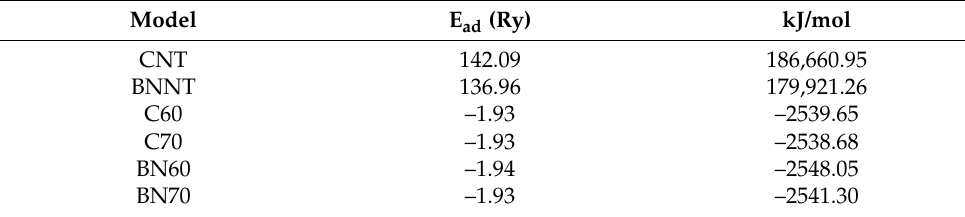
Table 3. Obtained adsorption energies of the phosgene-adsorbent nanomaterial